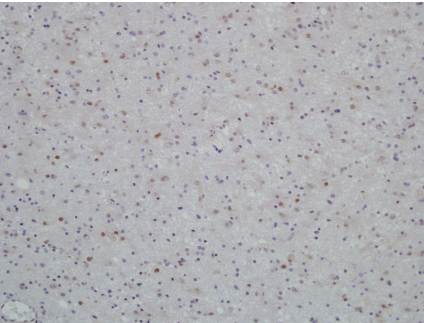
Figure 5: Microphotograph demonstrating significant P 53 immunopositivity of anaplastic astrocytoma.